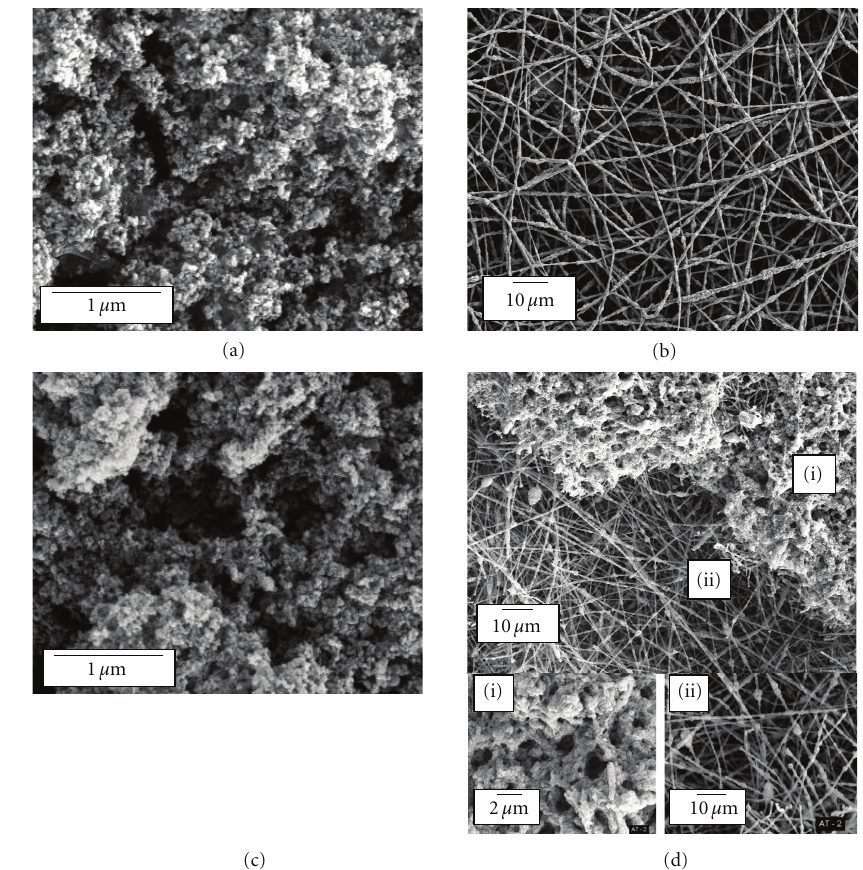
Figure 9: SEM micrographs showing morphological features of (a) cast and (b) electrospun P(3HB)-50wt% TiO 2 before photocatalytic decolorization experiment and (c) cast and (d) electrospun P(3HB)-50wt% TiO 2 after ten consequent decolorization experiments under solar